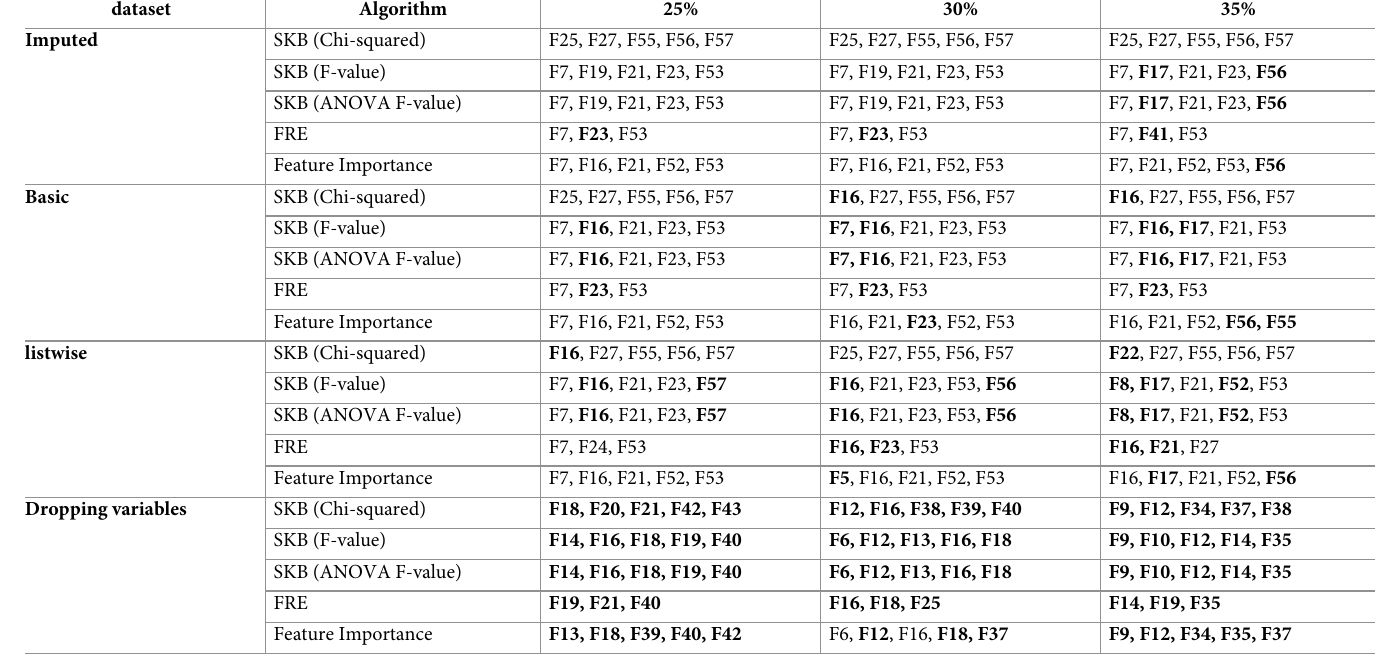
Table 21. Results of feature selection of simulated datasets.